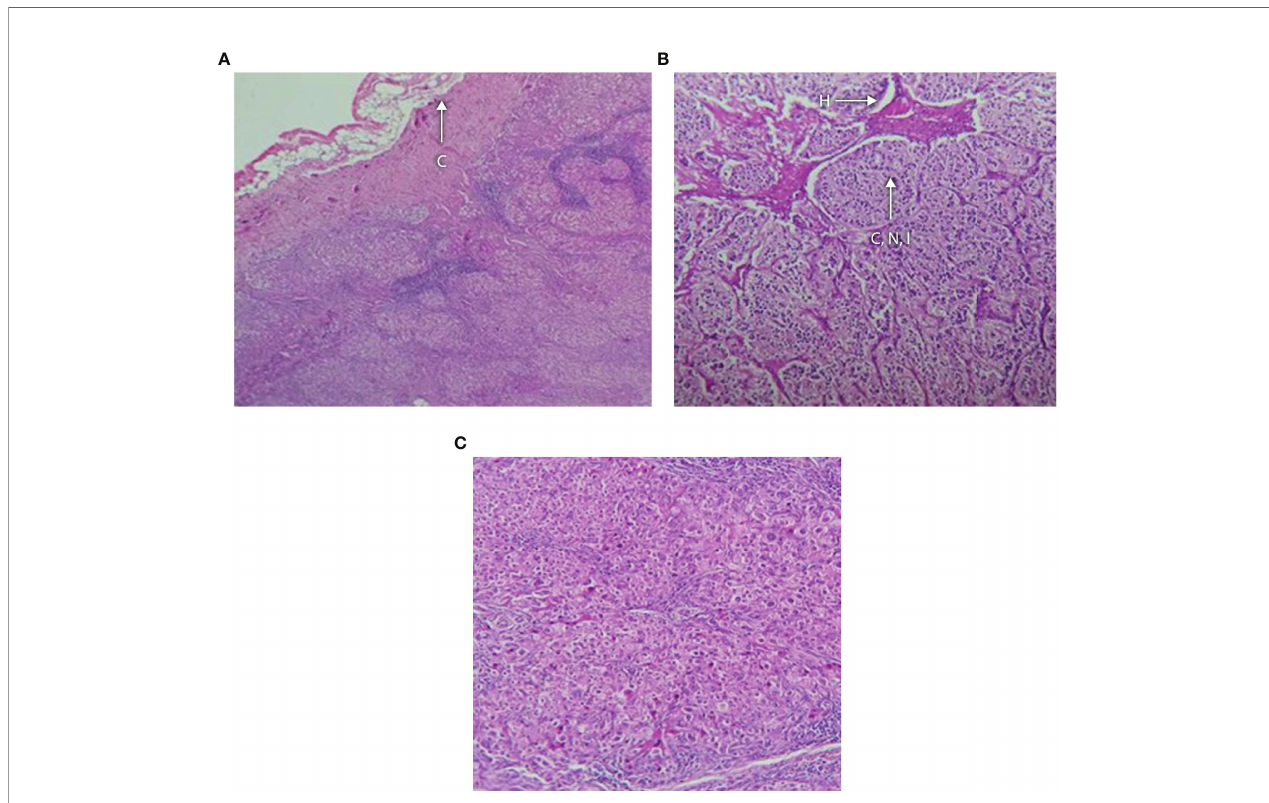
FIGURE 5 | (A – C) Histology of adrenal tumor from patient G II-1 following surgical removal showing (A) fi brous capsule with an underlying neoplasm containing hemorrhagic foci, no vascular or capsular invasion; (B) tumor composed of cells arranged in nests and cords separated by vasculature and lymphoid tissue; and (C) higher magni fi cation showing that the cells have distinct boundaries and clear cytoplasm with monomorphic nuclei and foci of oncocytic metaplasia. There is hyperchromasia of the nuclei and apoptosis. C, capsule; H, hemorrhagic focus; CNI, cords, nests and islands of